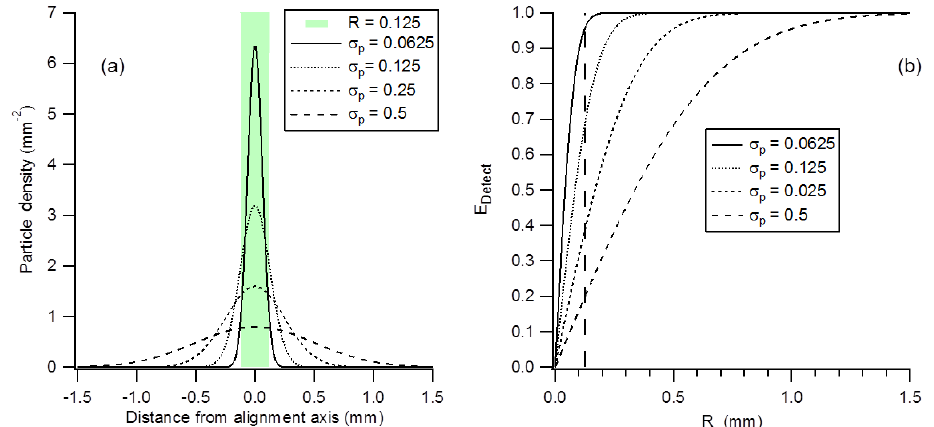
Figure 3. (a) The overlap of detection beam with a theoretical effective detection radius ( R ) of 0.125mm, with four normalised particle beams with widths σ p = 0 . 0625, 0.125, 0.25, and 0.5. (b) The relationship of the effective detection radius ( R ) and detection efficiency ( E Detect ) for a range of σ p values. R = 0 . 125mm is marked for